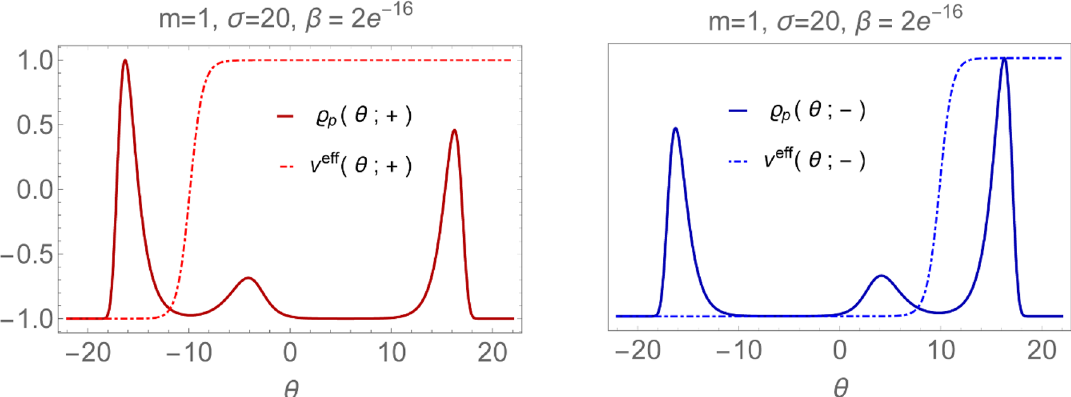
Figure 5 . The e(cid:11)ective velocities versus the normalized spectral densities % p ( (cid:18) ; (cid:6) ) = 2 (cid:26) p ( (cid:18) ; (cid:6) ) = ~ (cid:26) (cid:6) (cid:0) 1 where ~ (cid:26) (cid:6) is the height of the largest local maximum. The inverse temperature is (cid:12) = 2 e (cid:0) 16